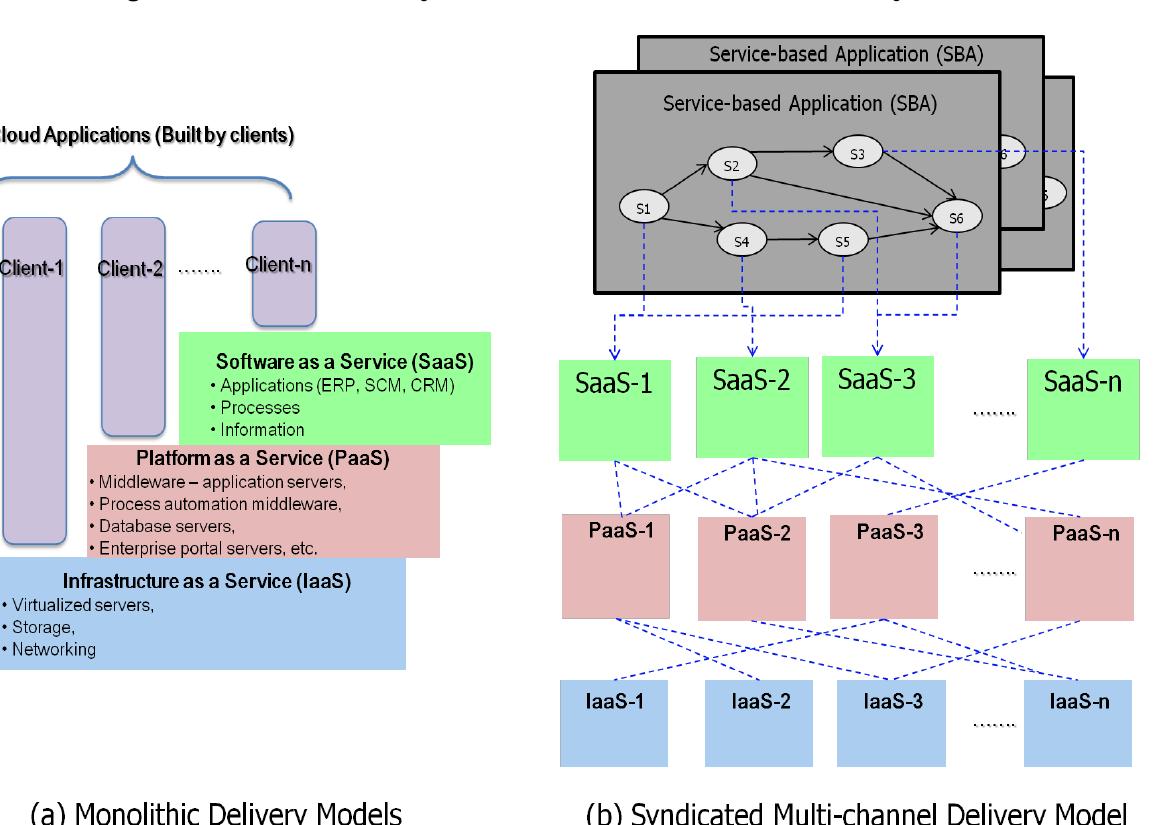
Figure 1. Monolithic vs . Syndicated Multi-channel Cloud Delivery